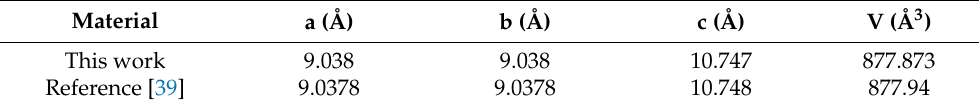
Table 1. The lattice parameter values and cell volume of the synthesized and reference